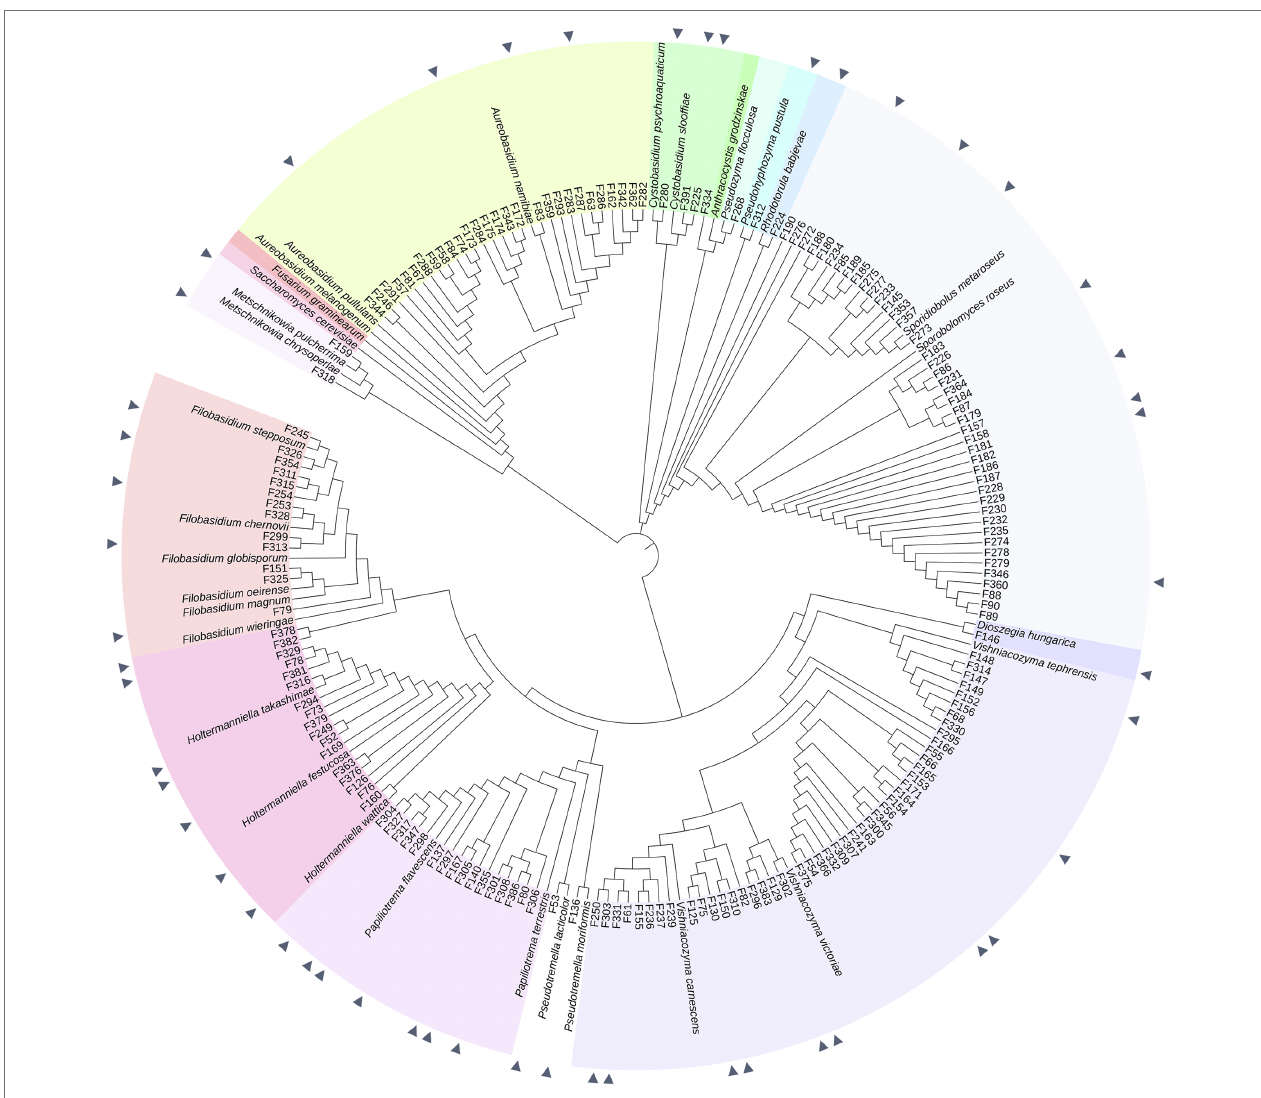
FIGURE 1 | Phylogeny of 175 phyllosphere yeasts isolated from the wheat flag leaf. Phylogeny is based on partial ITS sequences compared to NCBI database. Neighbor Joining tree was constructed with MEGA, MUSCLE for alignment. The iTol software was used to visualize and color-code the tree. Isolates indicated with a triangle are the 51 yeasts selected for the screening of different phenotypic and metabolic traits. Fusarium graminearum strain CBS 131786 was used as an outgroup. Type strains used are described in Supplementary Table S1